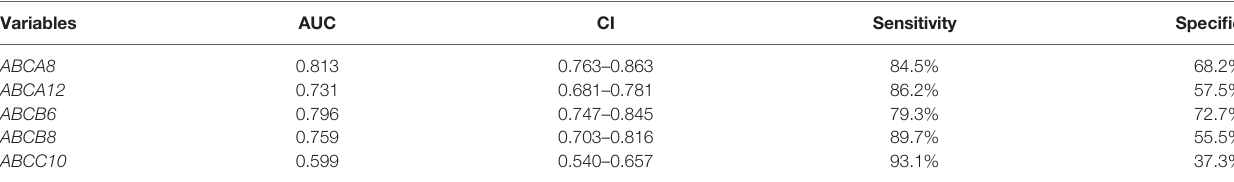
AUC, area under the curve; CI, con fi dence